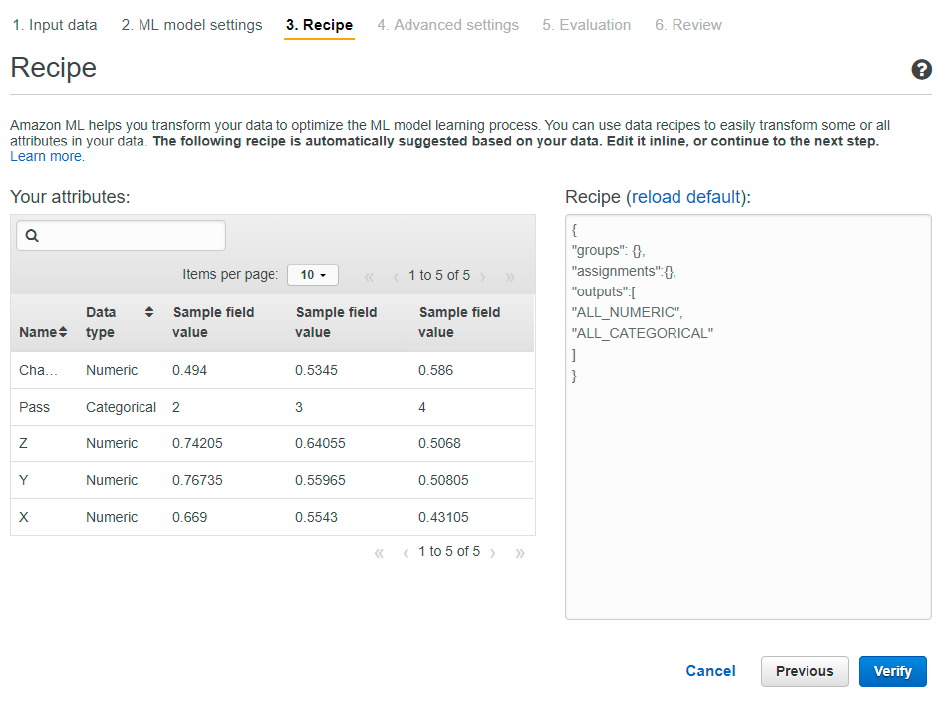
Figure 10. The data recipe for the AML model.